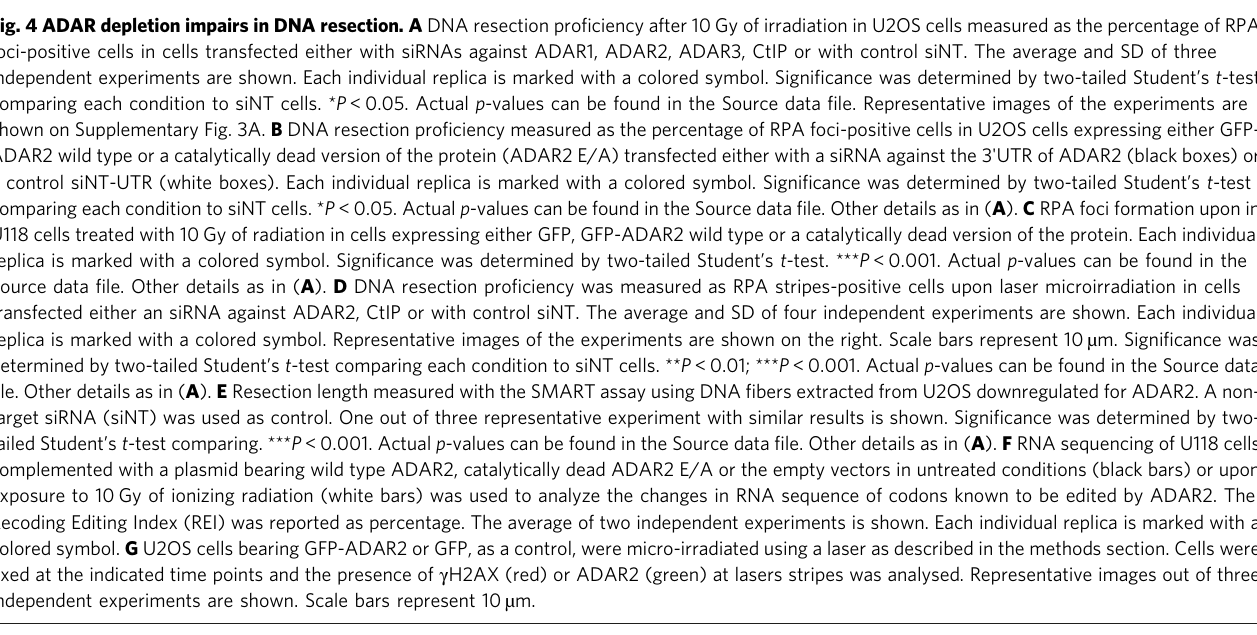
Fig. 4 ADAR depletion impairs in DNA resection. A DNA resection pro fi ciency after 10 Gy of irradiation in U2OS cells measured as the percentage of RPA foci-positive cells in cells transfected either with siRNAs against ADAR1, ADAR2, ADAR3, CtIP or with control siNT. The average and SD of three independent experiments are shown. Each individual replica is marked with a colored symbol. Signi fi cance was determined by two-tailed Student ’ s t -test comparing each condition to siNT cells. * P < 0.05. Actual p- values can be found in the Source data fi le. Representative images of the experiments are shown on Supplementary Fig. 3A. B DNA resection pro fi ciency measured as the percentage of RPA foci-positive cells in U2OS cells expressing either GFP- ADAR2 wild type or a catalytically dead version of the protein (ADAR2 E/A) transfected either with a siRNA against the 3'UTR of ADAR2 (black boxes) or a control siNT-UTR (white boxes). Each individual replica is marked with a colored symbol. Signi fi cance was determined by two-tailed Student ’ s t -test comparing each condition to siNT cells. * P < 0.05. Actual p -values can be found in the Source data fi le. Other details as in ( A ). C RPA foci formation upon in U118 cells treated with 10 Gy of radiation in cells expressing either GFP, GFP-ADAR2 wild type or a catalytically dead version of the protein. Each individual replica is marked with a colored symbol. Signi fi cance was determined by two-tailed Student ’ s t -test. *** P < 0.001. Actual p -values can be found in the Source data fi le. Other details as in ( A ). D DNA resection pro fi ciency was measured as RPA stripes-positive cells upon laser microirradiation in cells transfected either an siRNA against ADAR2, CtIP or with control siNT. The average and SD of four independent experiments are shown. Each individual replica is marked with a colored symbol. Representative images of the experiments are shown on the right. Scale bars represent 10 µ m. Signi fi cance was determined by two-tailed Student ’ s t -test comparing each condition to siNT cells. ** P < 0.01; *** P < 0.001. Actual p -values can be found in the Source data fi le. Other details as in ( A ). E Resection length measured with the SMART assay using DNA fi bers extracted from U2OS downregulated for ADAR2. A non- target siRNA (siNT) was used as control. One out of three representative experiment with similar results is shown. Signi fi cance was determined by two- tailed Student ’ s t -test comparing. *** P < 0.001. Actual p -values can be found in the Source data fi le. Other details as in ( A ). F RNA sequencing of U118 cells complemented with a plasmid bearing wild type ADAR2, catalytically dead ADAR2 E/A or the empty vectors in untreated conditions (black bars) or upon exposure to 10 Gy of ionizing radiation (white bars) was used to analyze the changes in RNA sequence of codons known to be edited by ADAR2. The Recoding Editing Index (REI) was reported as percentage. The average of two independent experiments is shown. Each individual replica is marked with a colored symbol. G U2OS cells bearing GFP-ADAR2 or GFP, as a control, were micro-irradiated using a laser as described in the methods section. Cells were fi xed at the indicated time points and the presence of γ H2AX (red) or ADAR2 (green) at lasers stripes was analysed. Representative images out of three independent experiments are shown. Scale bars represent 10 µ